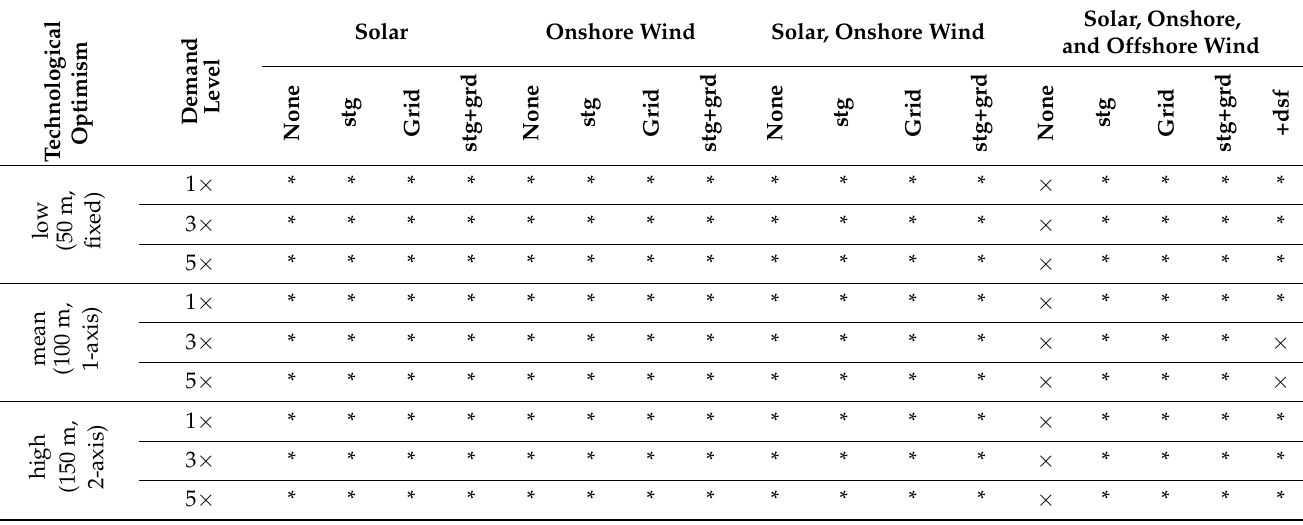
Table 3. Matrix of solved scenarios by